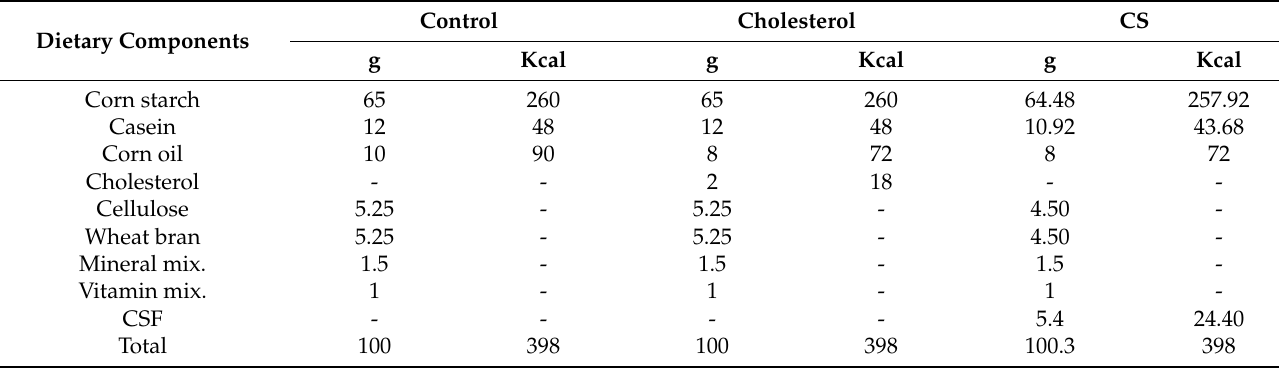
Table 6. Diet for the control, cholesterol, and CS-fed